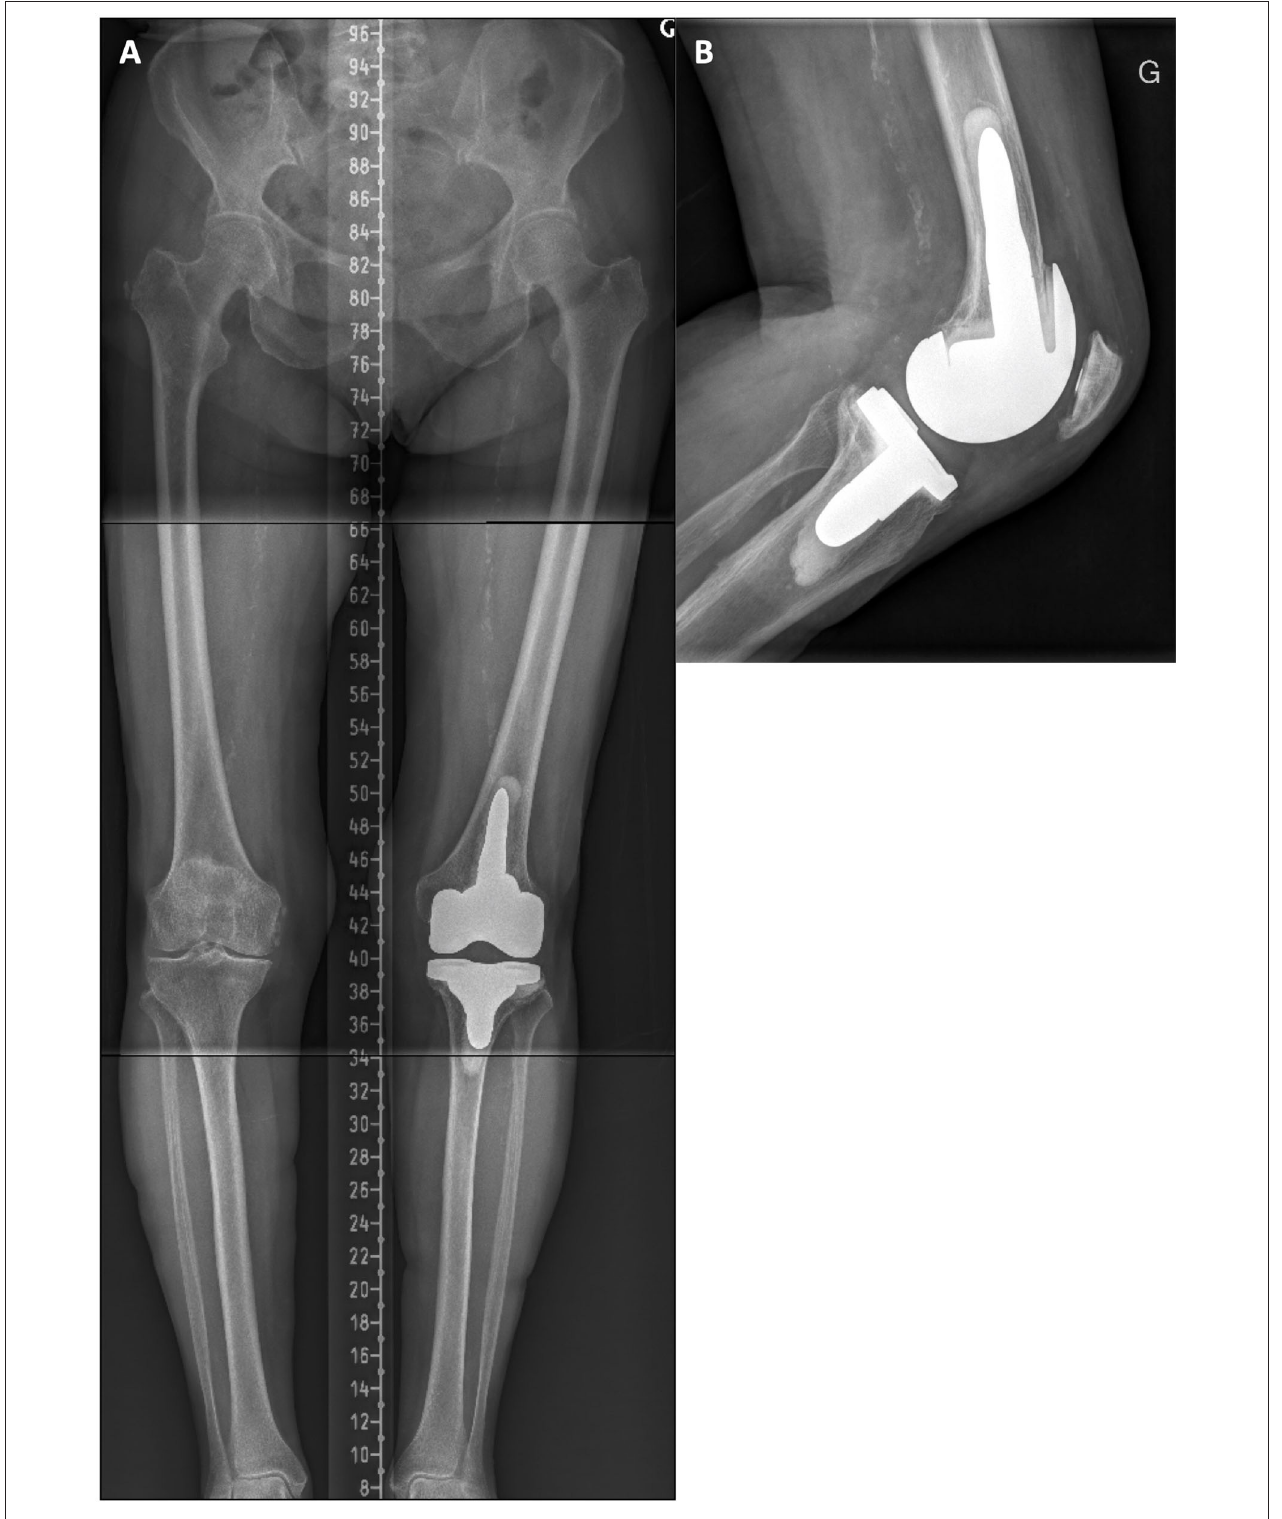
FIGURE 6 | (A) Post-revision standing long-leg X-ray of the left lower limb where the implant mDFA has been modified to 2.0 ◦ valgus and the mPTA at 3.0 ◦ varus (1.0 ◦ varus aHKA). As expected, the femoral cemented stems is not aligned with the femoral bone diaphysis. On the tibial side, to restore patient’s alignment, only a stubby stem could be used and comes in contact with the lateral cortex. (B) Left knee lateral view where the implant posterior tibial slope has been reduced to 3.0 ◦ . Because manufacturer recommendations for this implant is a neutral slope, we did not aim at patient’s contra-lateral side value of 6 ◦ .